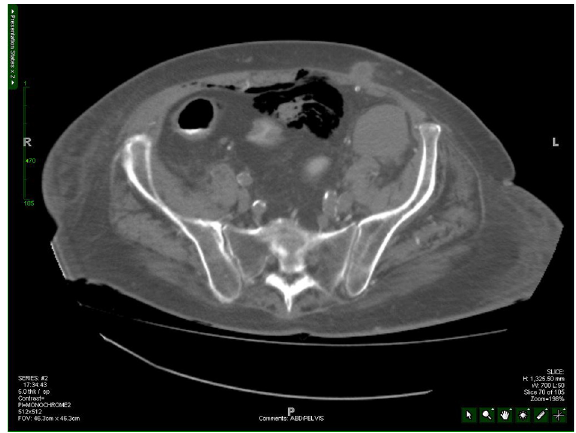
Figure 2 – Lateral extension of the gas-dissection in the pre- vesical space.